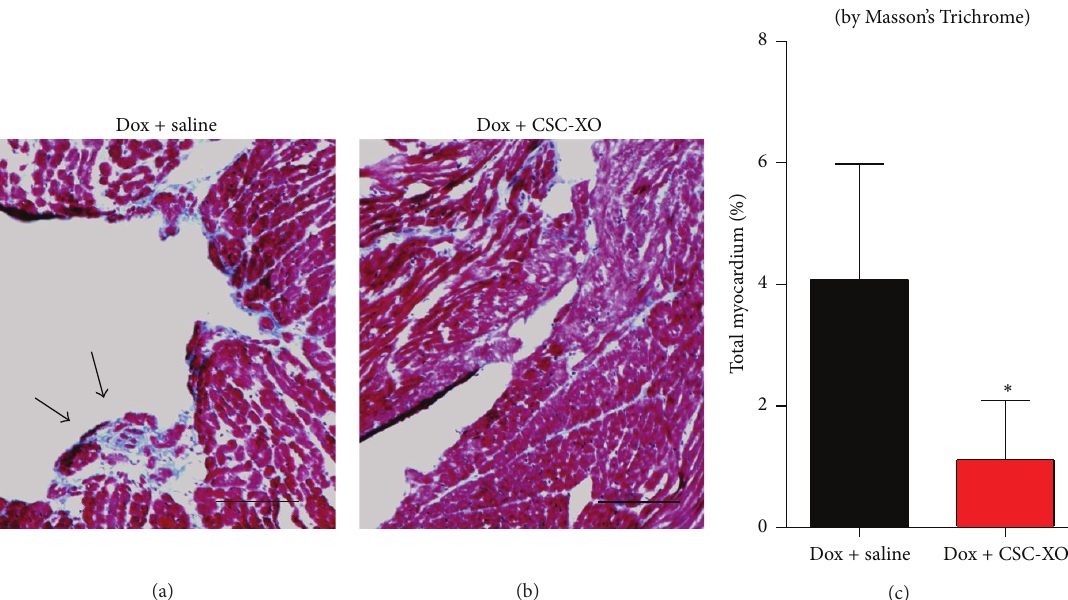
Figure 7: Masson’s Trichrome staining of heart sections from specimen receiving saline (a) and animals receiving CSC-XO (b) shows a decrease in the area of fibrotic lesions (c). Scale = 100 𝜇 m.